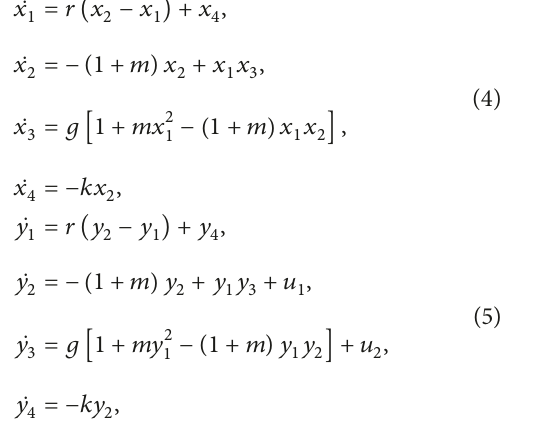
There seems to be two equilibria: 𝐸 1 (1/√−𝑚, 0, 0, (−1/√−𝑚, 0, 0, −𝑟/√−𝑚) ; however, because 𝑟/√−𝑚) and 𝐸 2 𝑚 is positive, hyperchaotic self-exciting homopolar disc dy- namo system (2) has no real